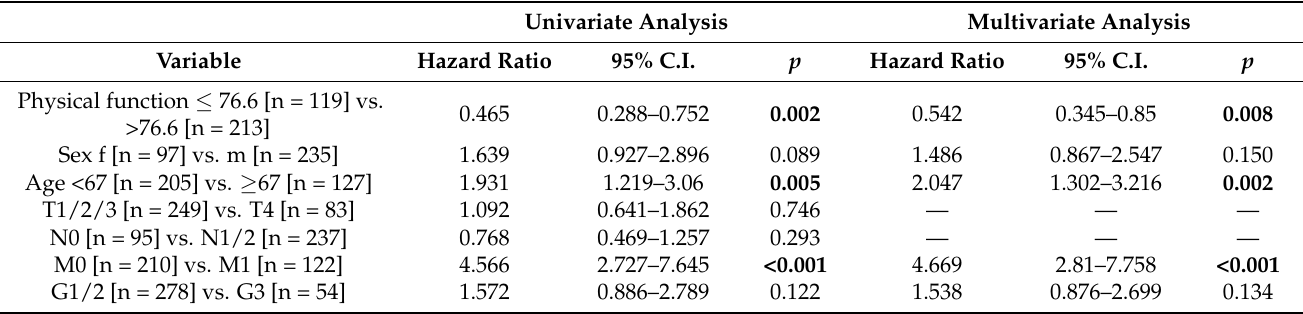
Table 2. Univariate and multivariate analysis of overall survival according to Cox’s proportional hazards model. Univariate Analysis Multivariate Analysis Hazard Ratio 95%